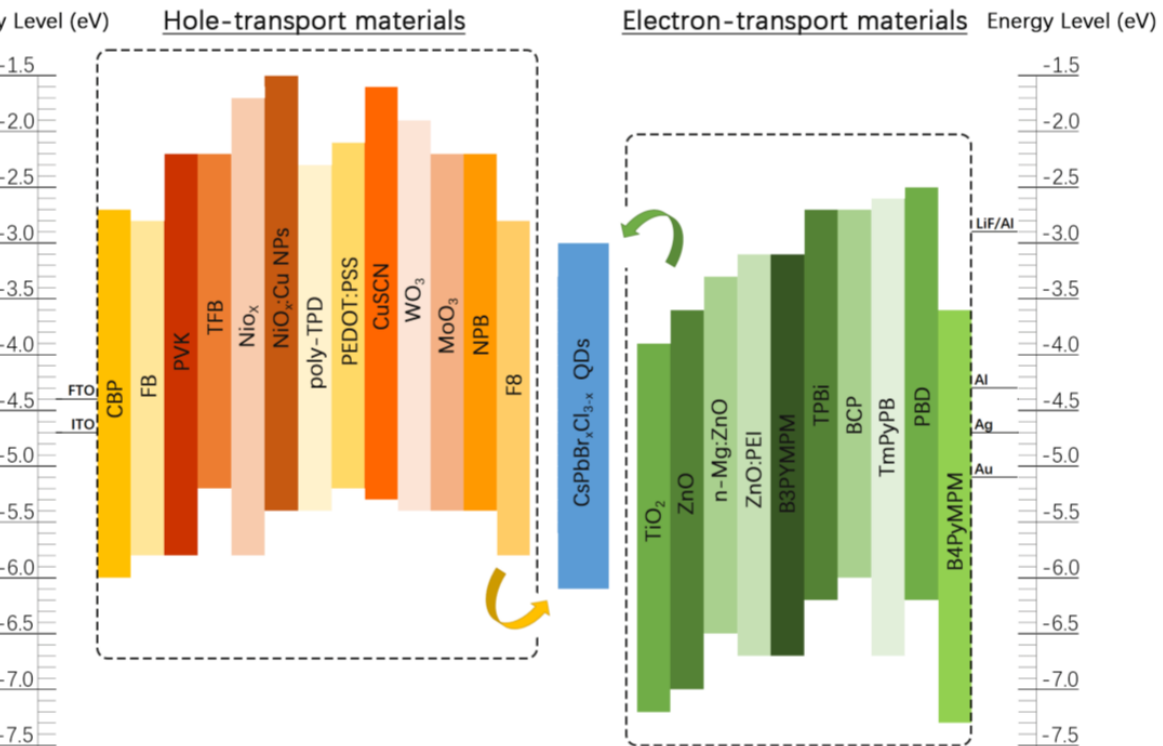
Figure 3. The energy diagram of the commonly used functional layers in PQD-LEDs.